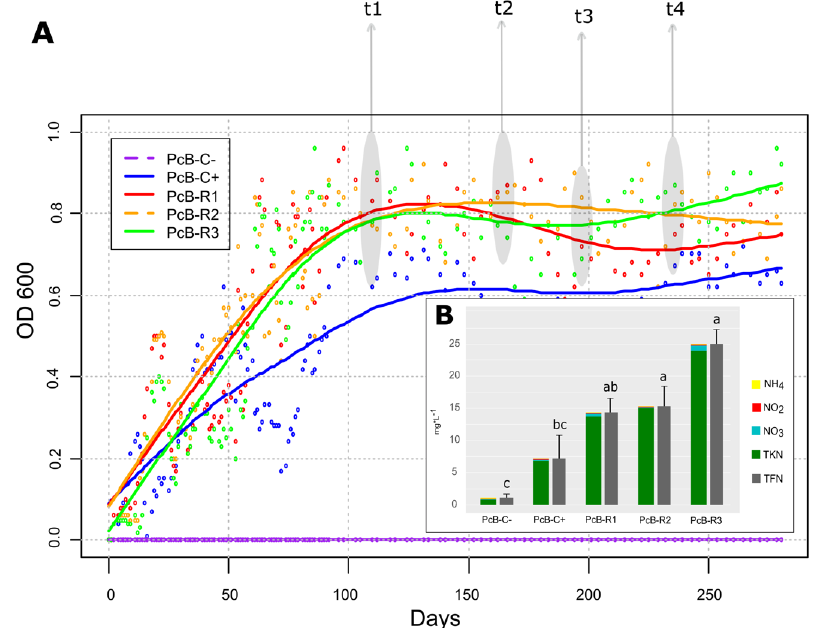
Figure 2. ( A ) Growth curve of the soil-adapted microbiome and Azotobacter vinelandii in the packed continuous bioreactors. ( B ) Nitrogen compounds accumulated in the bioreactors at the end of the experiment. TFN: Total fixed nitrogen; NH 4 : ammonium; NO 2 : nitrite; NO 3 : nitrate; TKN: total Kjeldahl nitrogen. Different letters show statistically significant differences (Tukey p < 0.05). (t1, t2, t3, t4): moments of sampling for DNA extractions and metabarcoding analysis.